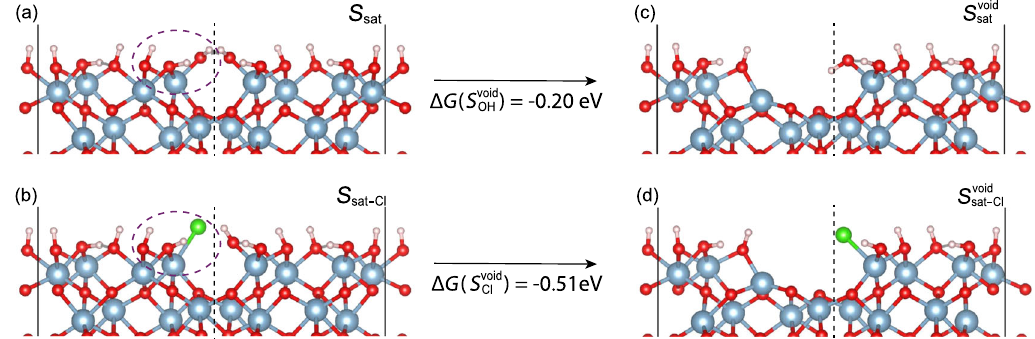
Fig. 7 Dissolution of Al cation from saturated surfaces with the GB effects. a, c show the surface structures corresponding to the terms in con fi guration (Fig. 3 (a)). b, d show the surface structures corresponding to the terms in Eq. (17) based on the S 1 Eq. (14) based on the S 1 GB con fi guration. The dashed vertical lines indicate the locations of the GB plane. For each reaction, the left con fi guration shows the initial saturated surface without/with Cl OH , and the dashed purple ellipse includes the surface atoms that are dissolved in aqueous conditions; the right con fi guration shows the fi nal states after Al(OH) 3 dissolution. After dissolution, the Cl atom is substitutionally adsorbed on an under- coordinated OH site (CN = 1) on the right side of the GB plane. Free energy variations calculated using Eq. (15) and Eq. (18) are indicated by relevant arrows and also tabulated in Table